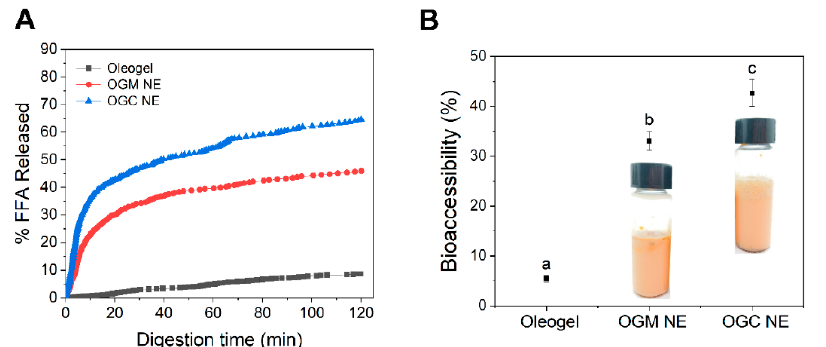
Figure 7. ( A ) Release profile of free fatty acids in oleogel, the OGM-stabilized oleogel-based nanoemulsions (NE), and the OGC-stabilized oleogel-based NE; ( B ) The bioaccessibility of astaxanthin in oleogel, the oleogel-based nanoemulsions containing OGM and the oleogel-based nanoemulsions containing OGC after in vitro digestion. The insets show the visual observation of the corresponding astaxanthin-loaded oleogel-based nanoemulsions. Mean values ( n = 3) with different lowercases represented significant differences ( p < 0.05).